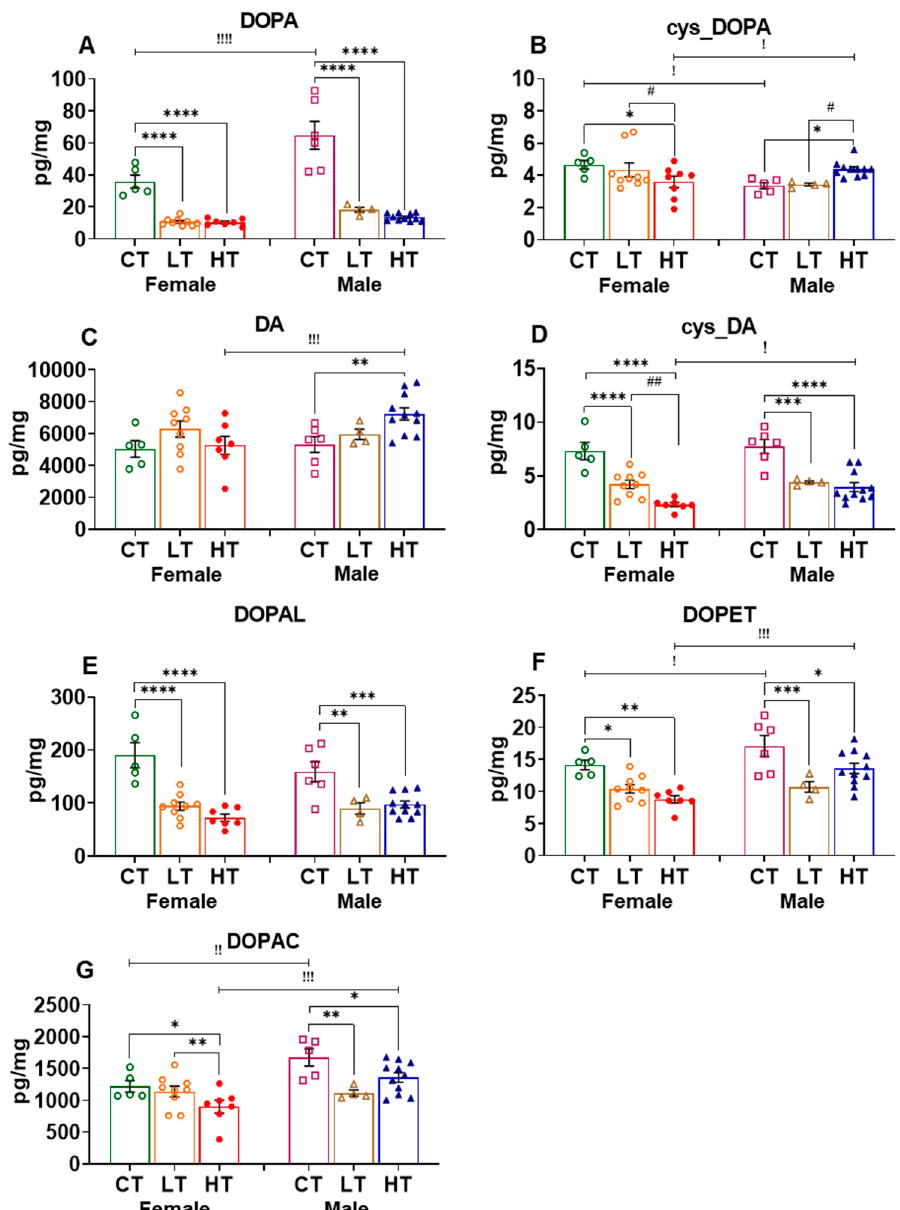
Figure 3. Content of dopamine and its metabolites in the nucleus accumbens (NAc) after 30 days of withdrawal from METH SA. ( A ) DOPA, ( B ) cys_DOPA, ( C ) DA, ( D ) cys_DA, ( E ) DOPAL, ( F ) DOPET, and ( G ) DOPAC in female and male rats. * p < 0.05, ** p < 0.01, *** p < 0.001, **** p < 0.0001. # p < 0.05, ## p < 0.01. ! p < 0.05,!! p < 0.01,!!! p < 0.001, !!!! p < 0.0001.